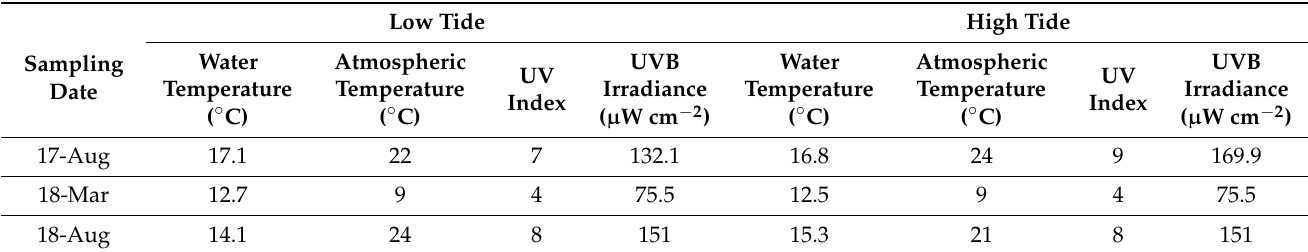
Table 1. Information about water temperature and atmospheric temperature, UV index, and UVB irradiance during low and high tides of all sampling